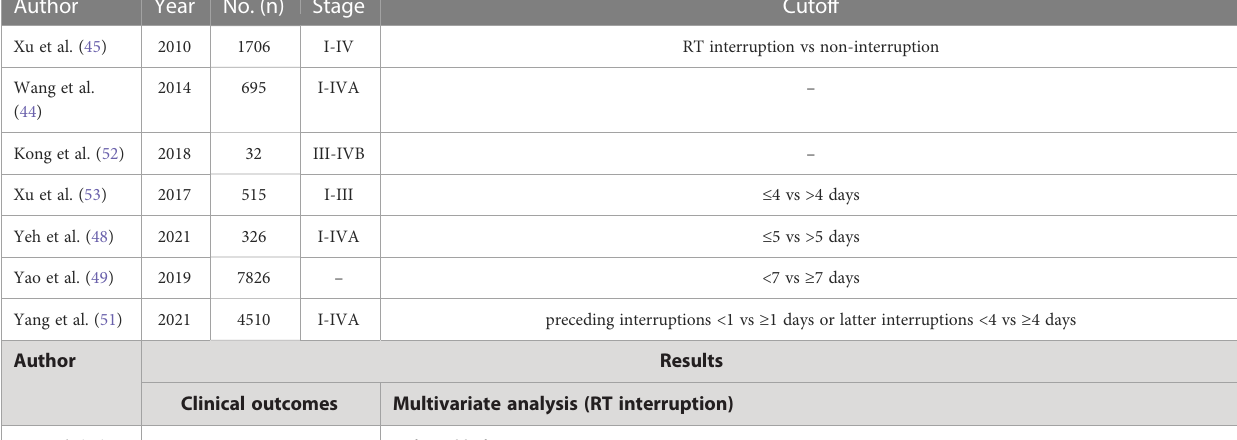
TABLE 2 Real-world data on the impact of radiotherapy